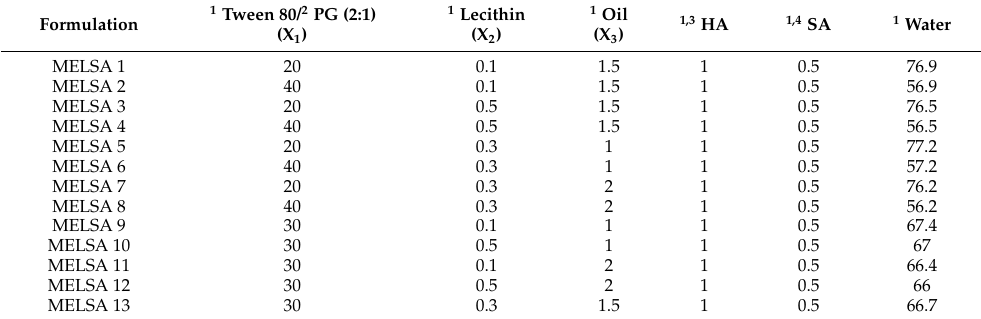
Table 1. Composition of fluid O/W microemulsions formulated with salicylic acid.